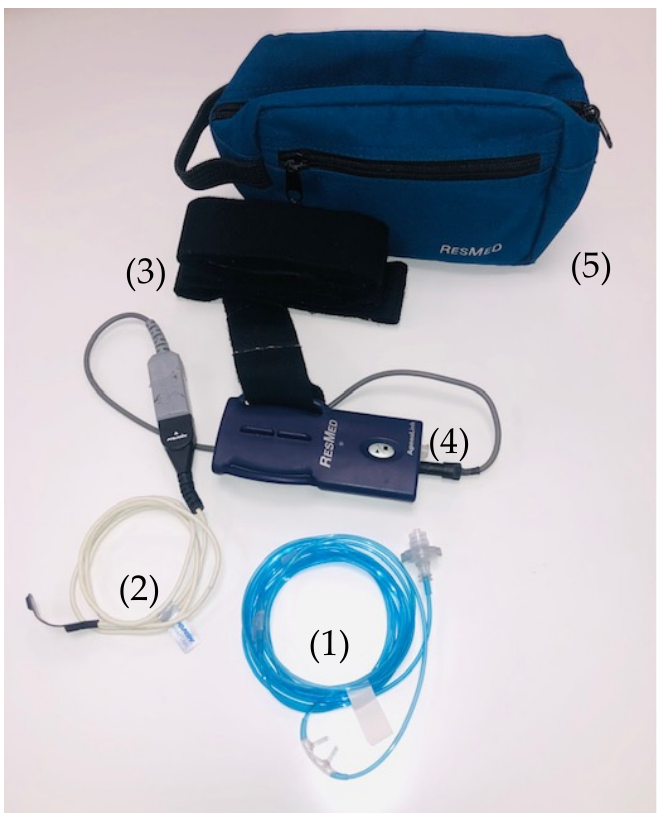
Figure 2. Apnea Link Air polygraphic system (Resmed ® Spain): (1) Pressure nasal canula; (2) Pulse oximeter; (3) Piezoelectric chest belt; (4) Registration box; (5) Transport bag. (See methodology section).